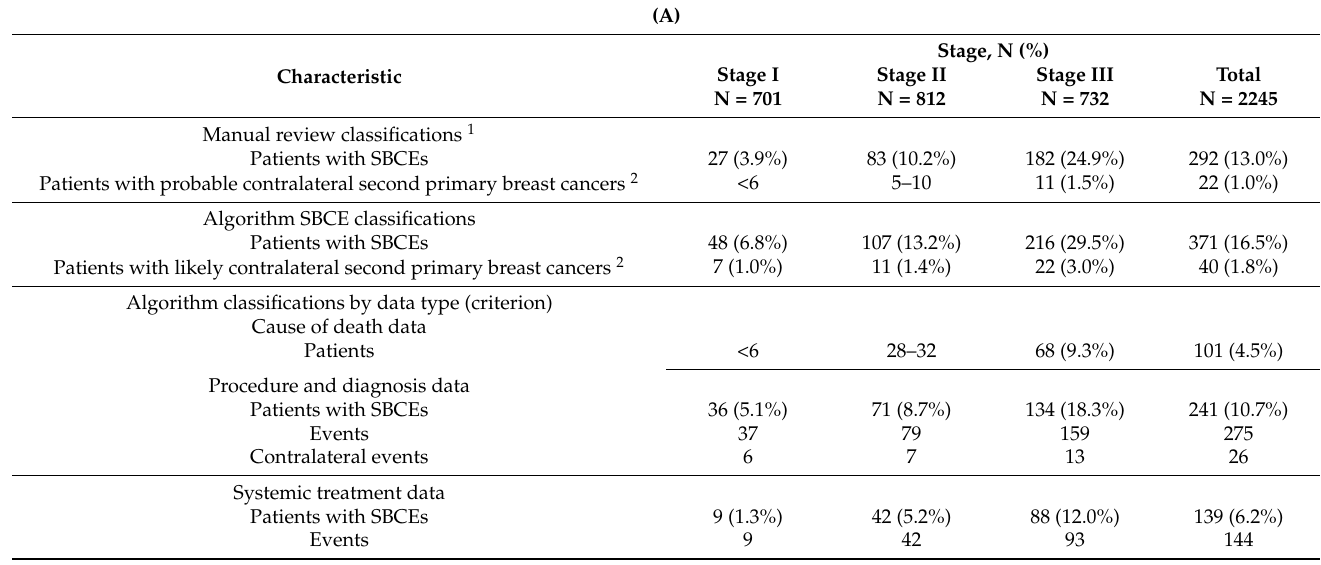
Algorithm SBCE classifications Patients with SBCEs Algorithm classifications by data type (criterion) Cause of death